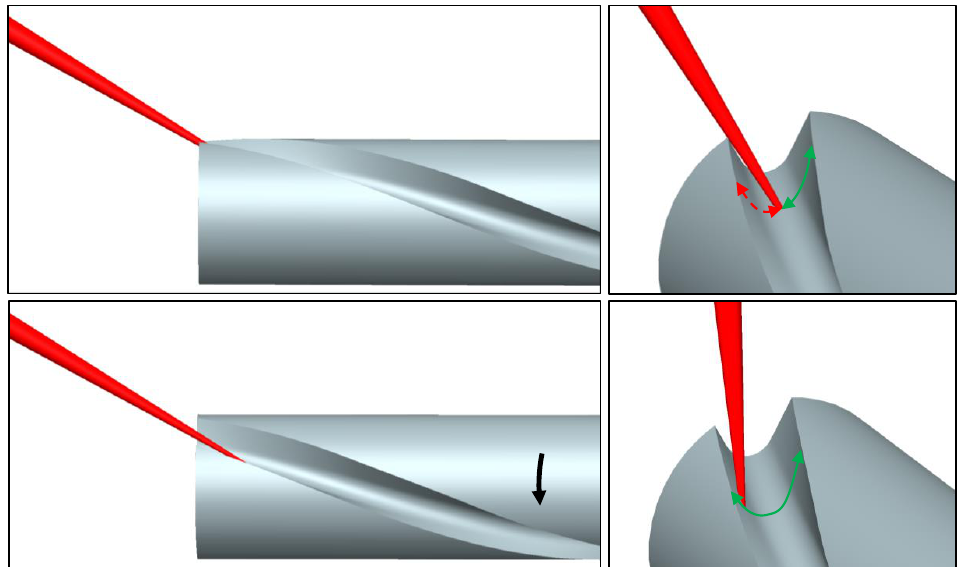
Figure 14. Visualisation of the beam-workpiece intersection resulting from the helix angle of the groove ( top ). Because of self-shading, a part of the cross section cannot be accessed (red arrow). Bottom : By rotation of the scan path around the cylindrical axis (black arrow) the full range of the groove can be accessed by the scan path